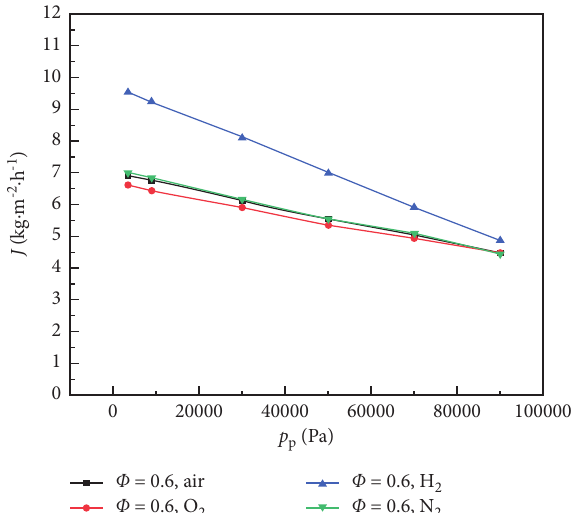
Figure 8: Permeate flux of four noncondensable gas under different pressure of the permeate side. T V F,in � 0.145m/s, V P,in � 0.002m/s, P F � P 0 , W NaCl � 0.